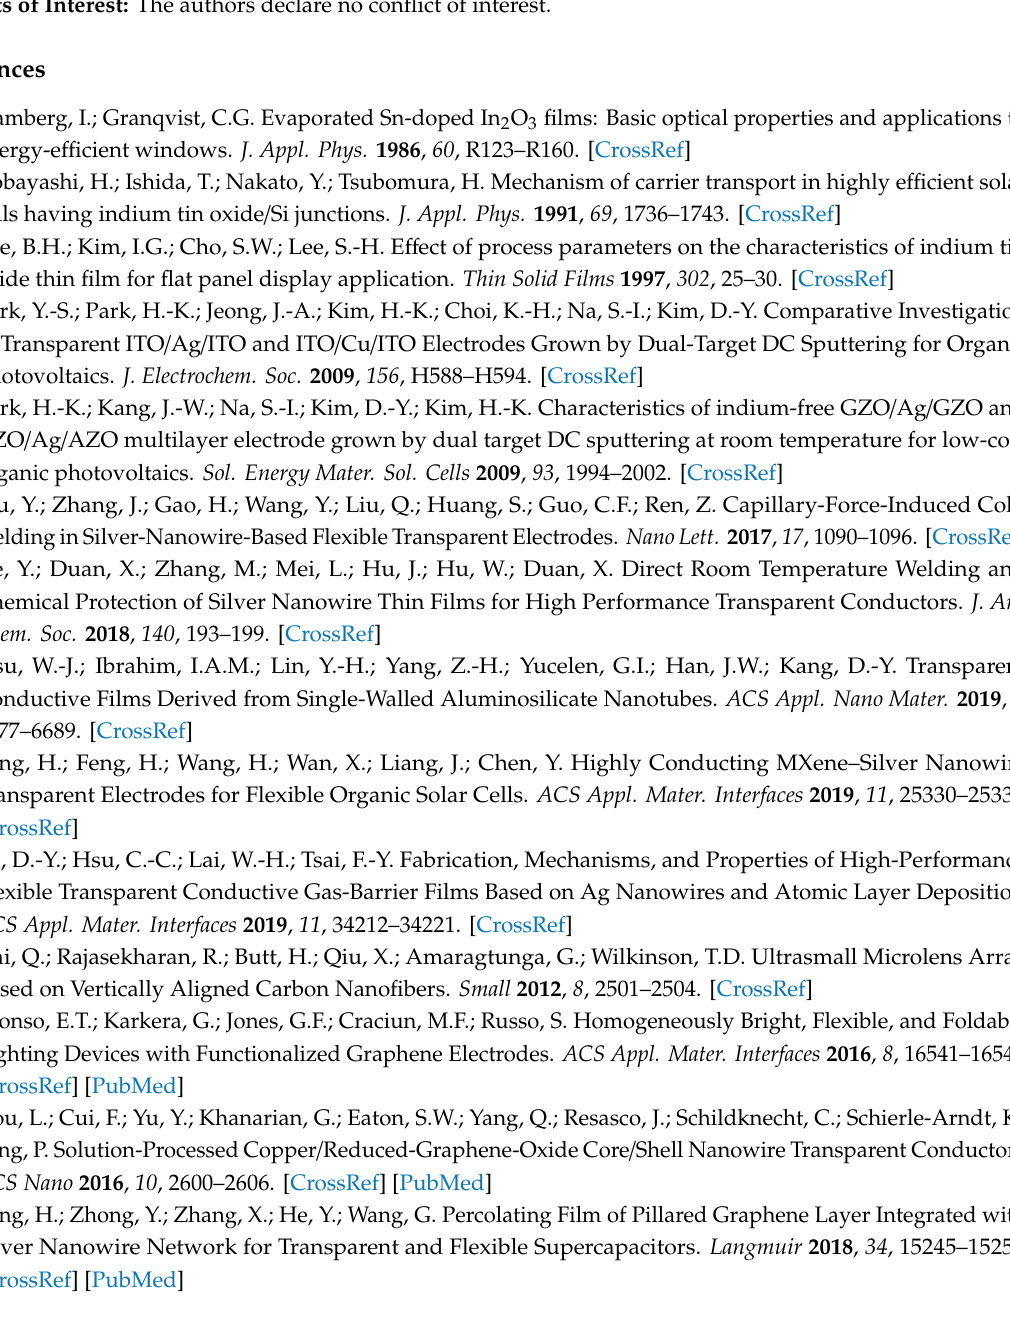
Table S1: Optical transmittance and sheet resistance of the ITO / PET and 1-layer-graphene / ITO / PET substrates; Table S2: The additional data for the optical transmittance, sheet resistance, and figure of merit (FOM) of the ITO / PET, 1-layer-graphene / ITO / PET, and 2-layer-graphene / ITO / PET substrates; Figure S1: A plot of the optical transmittance as a function of wavelength of incident light of the UV-visible spectrometer for di ff erent substrates; Figure S2: A plot of the etch rate in the lateral (or in-plane) direction for the di ff erent samples. Author Contributions: E.-S.C. and J.-H.H. conceived and designed the experiments. H.S.R., H.-S.K., D.K., and S.J.L. carried out the experiments and theoretical calculation, and E.-S.C., J.-H.H., S.J.K., and W.C. analyzed the data. E.-S.C., J.-H.H., and W.C. wrote the paper. All authors have read and agreed to the published version of the